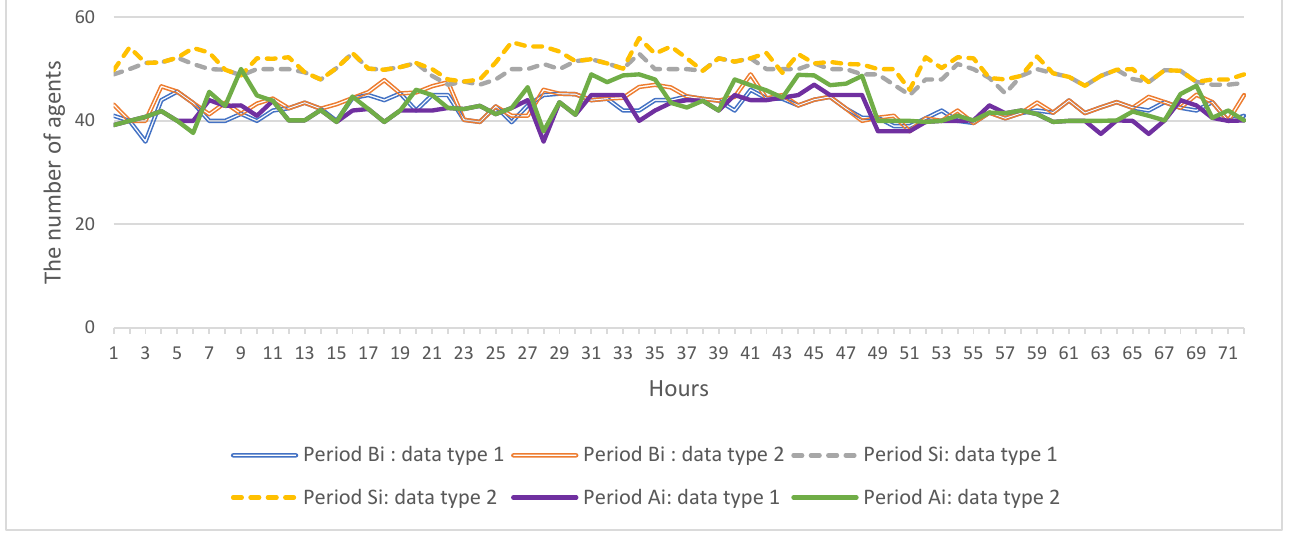
Figure 9. The number of agents from actual data of type 1 and type 2. Part 2: Simulation: Model (1) and Model (2).